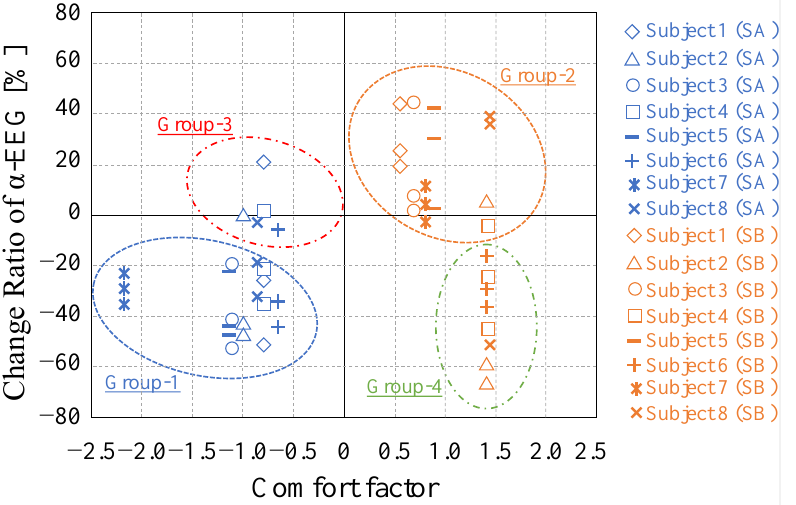
Figure 10. Results of the non-hierarchical cluster analysis by the k-means method. Blue plots indicate scores for SA (white noise), while orange plots indicate scores for SB (murmuring river sound). Each marker indicates an individual subject. All 48 data including two types of sound sources (SA and SB) and three experiments with eight subjects were classified into Group-1 to Group-4.